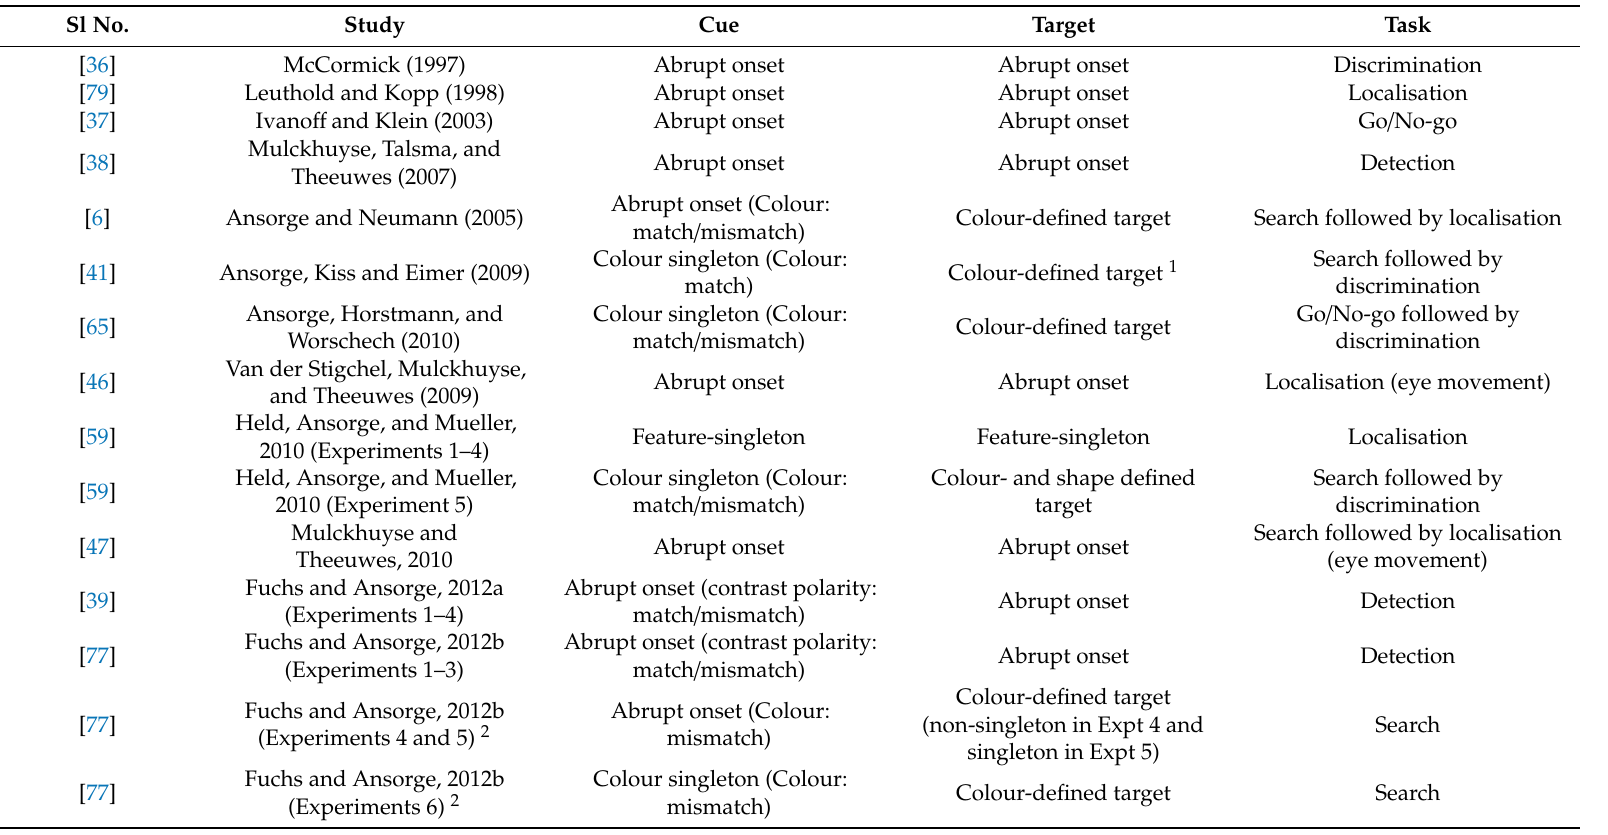
Table 1. Studies examining the nature of attentional control over unconscious processing using variations of the spatial orienting paradigm. Sl